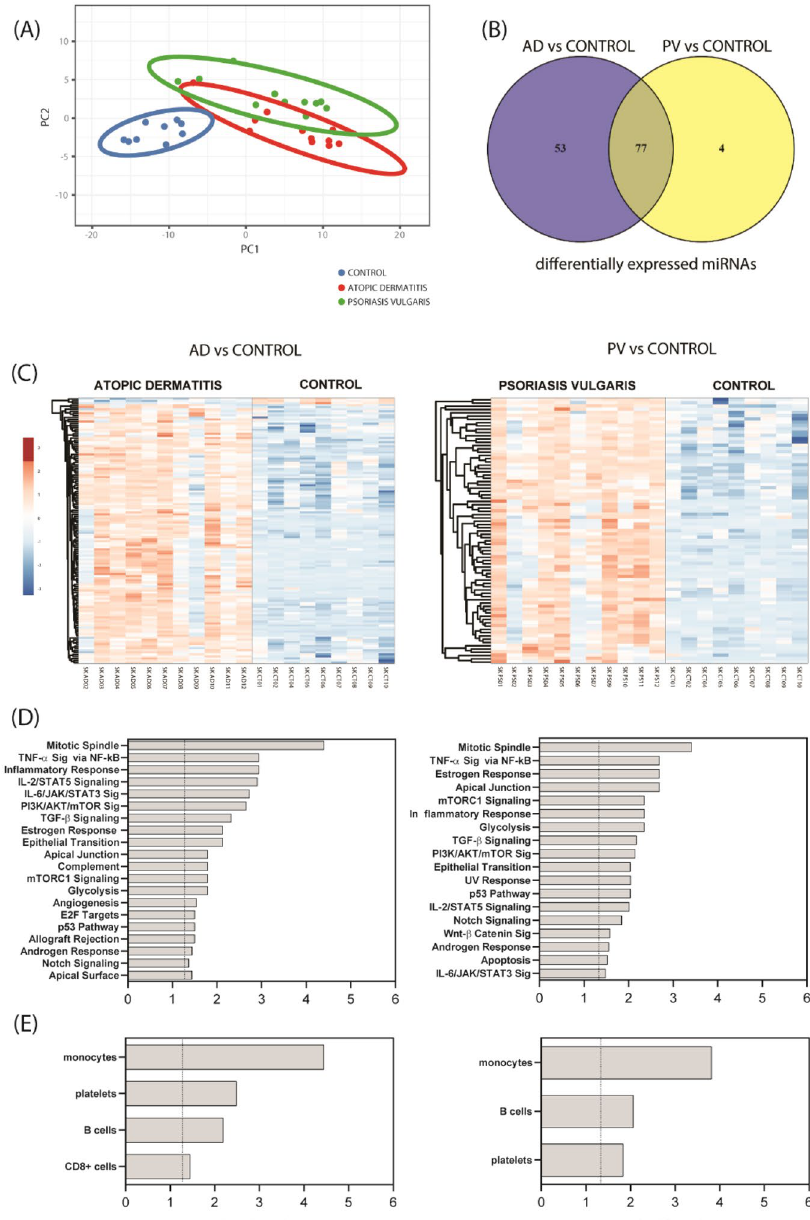
Figure 1. Differentially expressed miRNAs in skin tissue of AD and PV patients. ( A ) Principal component (PC) analysis of the miRNA profiling of the skin samples. Unit variance scaling is applied to rows; SVD with imputation is used to calculate principal components. X and Y axis show principal component 1 and principal component 2 that explain 64.2% and 6.3% of the total variance, respectively. Prediction ellipses are such that with probability 0.95, a new observation from the same group will fall inside the ellipse. N = 31 data points. ( B ) Venn diagram comparing the number of differentially expressed miRNAs from AD vs controls with PV vs controls analyses. ( C ) Hierarchical clustering analysis: heat map showing the differentially expressed miRNAs by studied groups plotted using ClustVis (correlation distance measure and average linkage function). Score values of principal component analysis (PCA) calculated from log2 values from the array miRNA expression signals were used. Clustered up- and down-regulated genes in AD and/or PV vs controls and AD vs PV from the profiling cohort. ( D ) Enrichment analysis of skin tissue samples for biological pathways performed with Enrichr. ( E ) Sites of expression of differentially expressed miRNAs-gene targets of skin tissue samples performed with Target Scan and